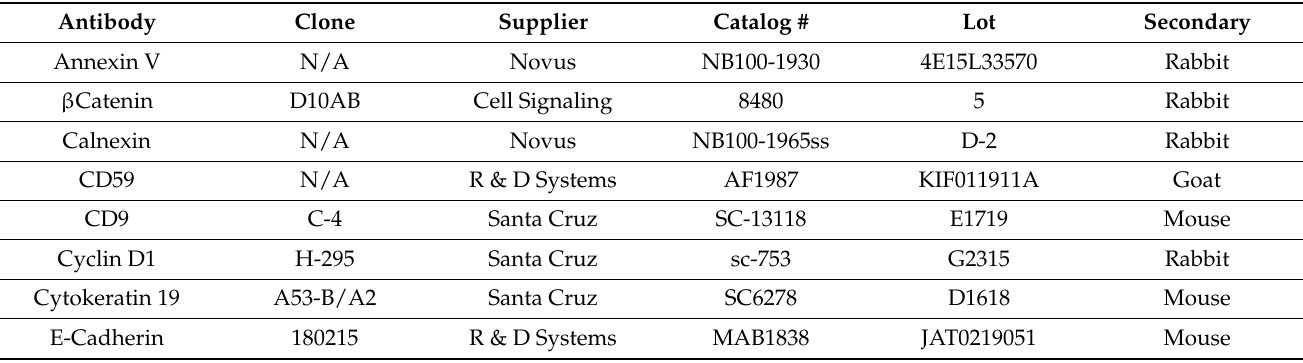
Table 2. Wes Antibody